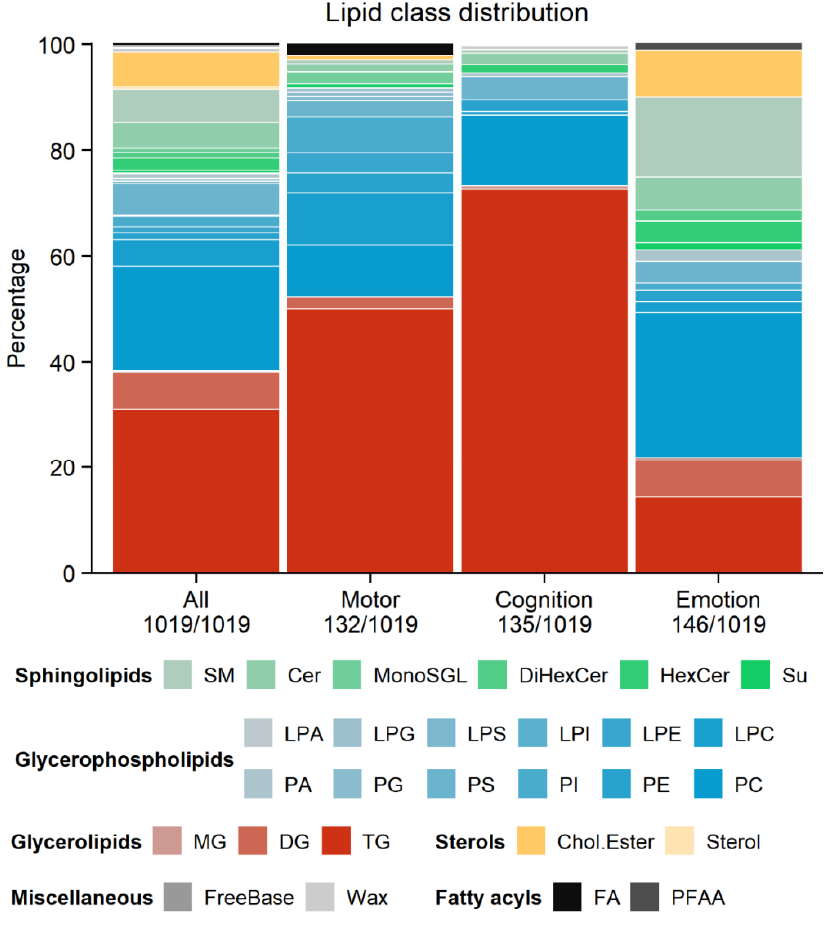
Figure 5. Distribution of lipid classes and subclasses for the selected lipids within each clinical model (motor, cognition and emotion).